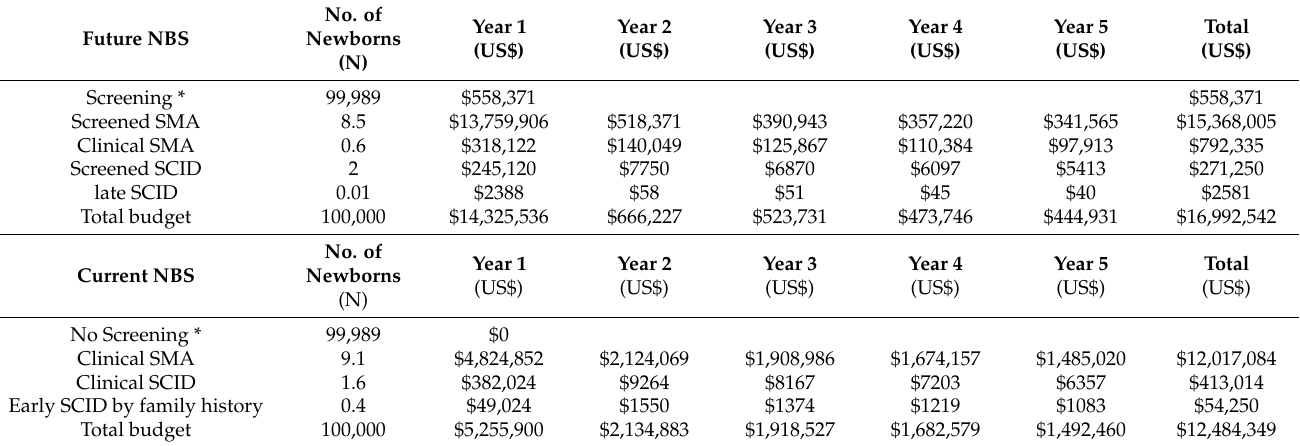
Table 2. Costs of future NBS with screening for SCID and SMA and treating with early HSCT and gene therapy and current NBS without screening with late HSCT and nusinersen treatment for a cohort of 100,000 newborns (undiscounted US$ 2018 value).